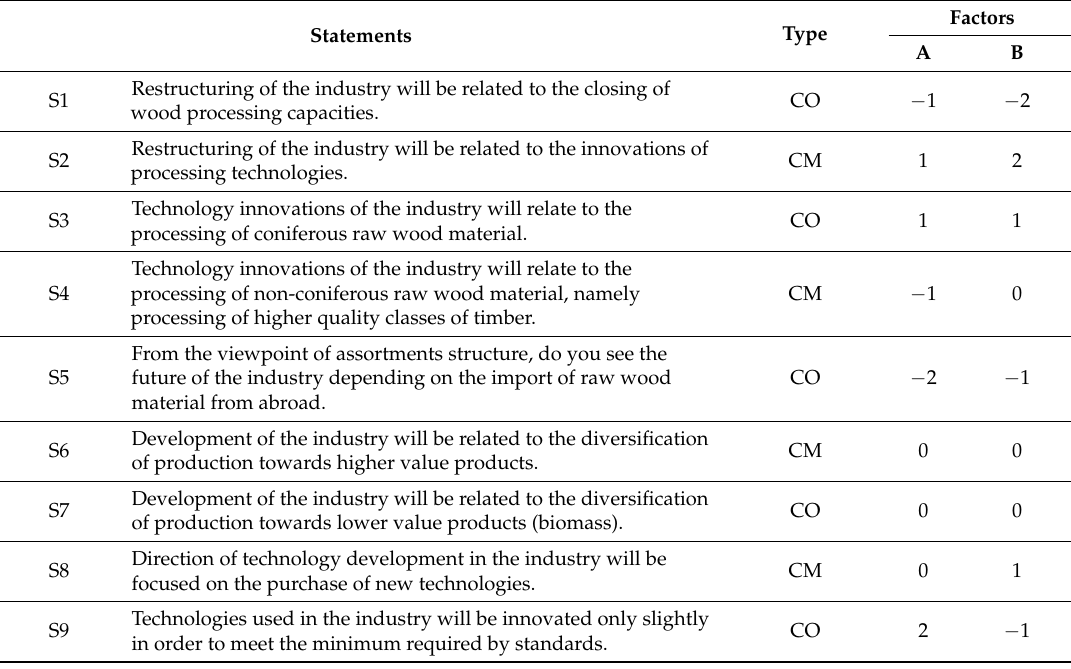
Table 1. Factor scores generated from Q-methodology testing of different company stakeholders in the forestry-wood sector in Slovak Republic.